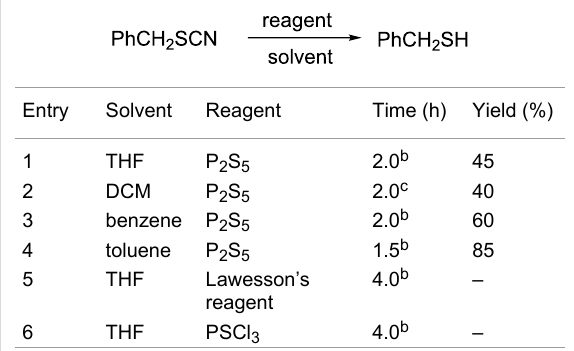
Table 1: Effect of reaction medium and reagents on conversion of thio- cyanates to thiols.